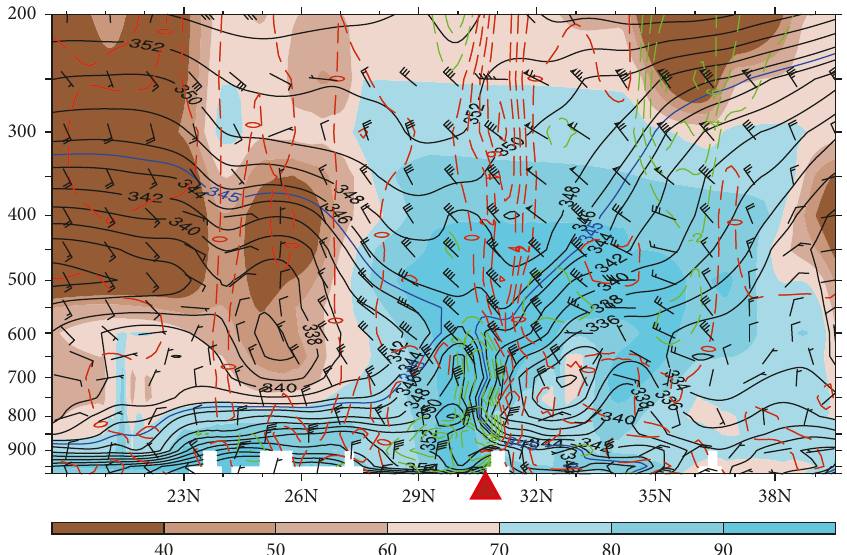
Figure 5: Vertical cross section along 116.5 ° E of equivalent potential temperature black solid lines, unit: K the blue line is the isoline of 345 K, horizontal winds (wind barbs), temperature advection (red dashed lines: · unit: %). The red triangle denotes the key area of the rainstorm and the vertical coordinate is pressure (unit: